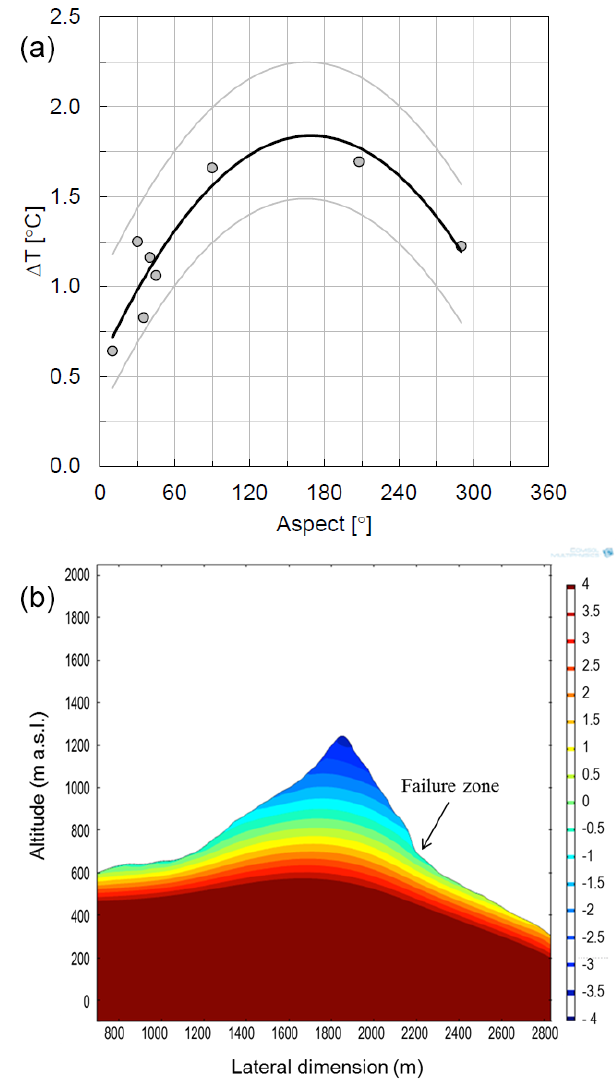
Figure 11. (a) Annual temperature difference ( (cid:49)T ) between cal- culated air temperature and measured rock face temperatures and aspect dependency as derived from the rock wall temperature data. The points represent mean values and the black line is the best poly- nomial fit to the data ( R 2 = 0 . 84). The grey lines show the polyno- mial fit to the interquartile range of (cid:49)T ; (b) 3-D transient heat mod- elling of the subsurface temperature field based on values identified in (a) . Figure shows a slice transecting the mountain from south (left) to north